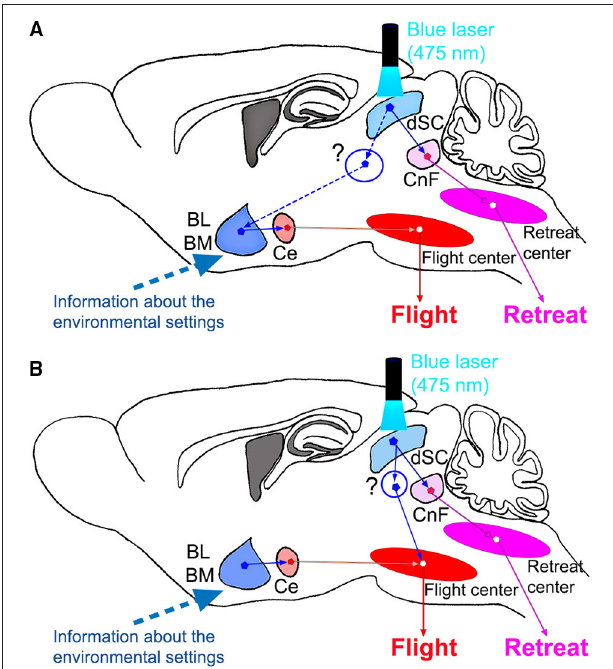
FIGURE 5 | Proposed schematic diagrams of the circuit organization underlying the environment dependency of the defense responses. (A) Activation of flight response by dSC via the amygdala. (B) Amygdala modulates the flight center, which is activated directly by the dSC stimulation. CnF, cuneiform nucleus; dSC, deep layers of the superior